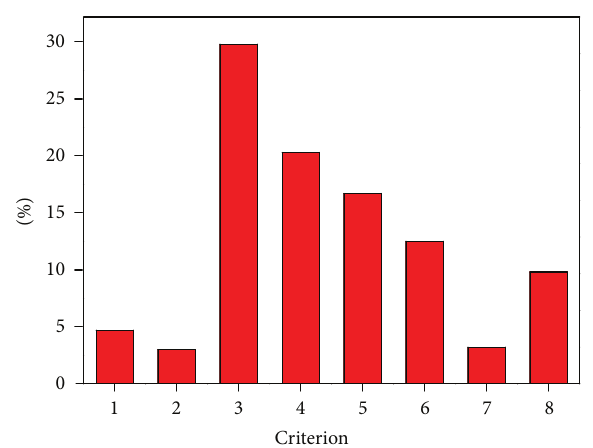
Figure 10: Frequency of application of composite material failure criteria. 1 Principal strain criterion; 2 strain energy density criterion; 3 the maximum strain criterion; 4 the maximum stress criterion; 5 Tsai-Hill criterion; 6 Tsai-Wu criterion; 7 strain-strain rate criterion; 8 other